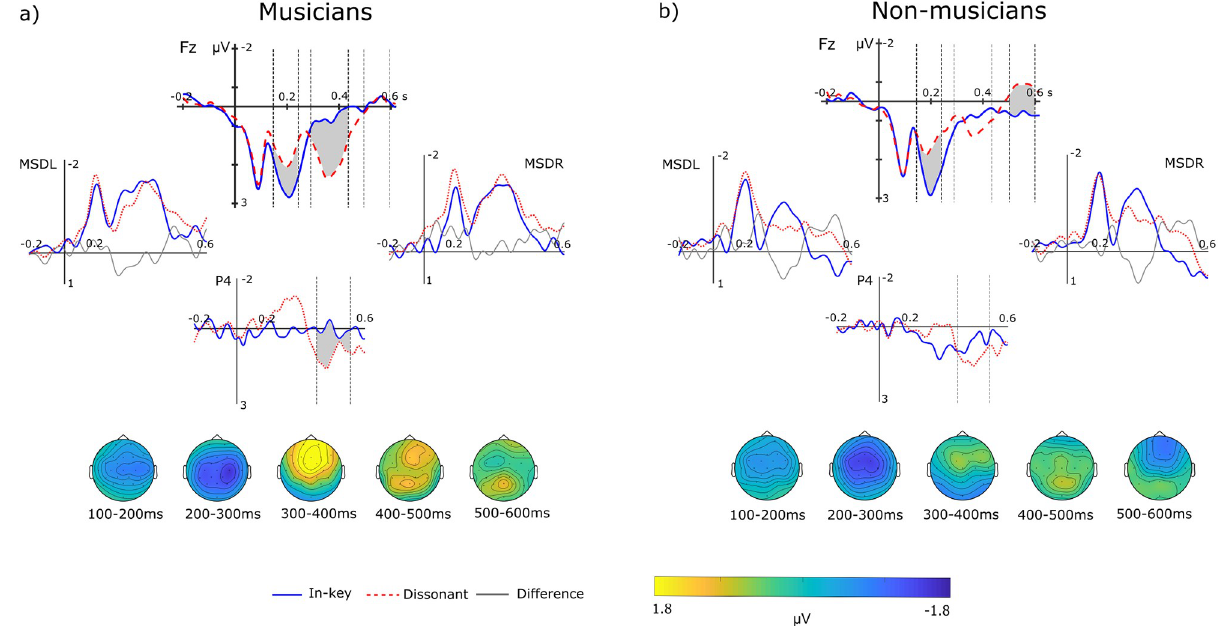
Fig 5. Experiment 2: Event-related potentials of musicians and non-musicians. Graphs include grand-average ERPs and topographical distribution of the difference waves (dissonant minus in-key) of musicians (a) and non-musicians (b) appearing in 50% of the sequences. Dotted vertical lines indicate the limits of the time windows of interest analysed. Shaded areas correspond to significant ERP effects, which are best seen in electrode F8. Left (MSDL) and right mastoidal (MSDR), and parietal (P4) are also shown. Topographical plots depict the grand-average difference wave to better observe the evolution of the topographical distribution of each ERP of